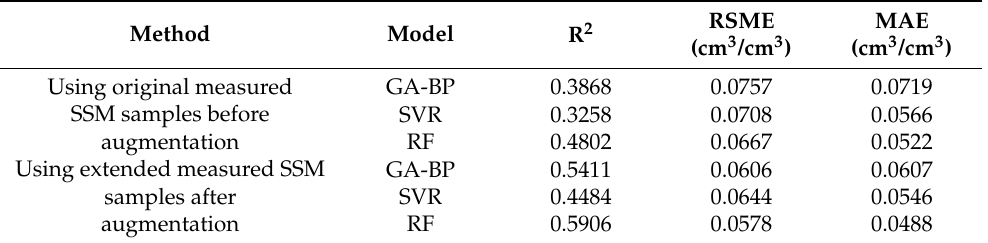
Table 3. Comparison of SSM inversion accuracy before and after sample